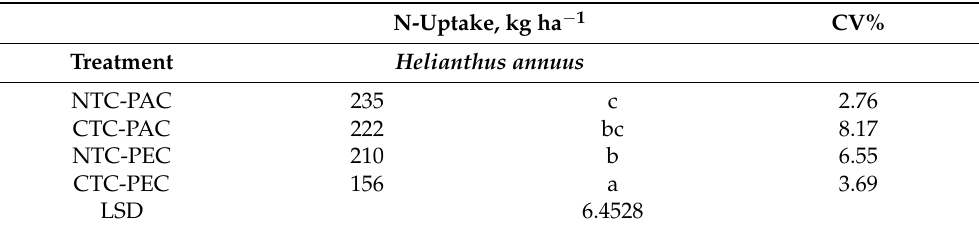
Table 5. N-uptake of the Helianthus annuus cultivation in the 4 different soil practice treatments in the first growing